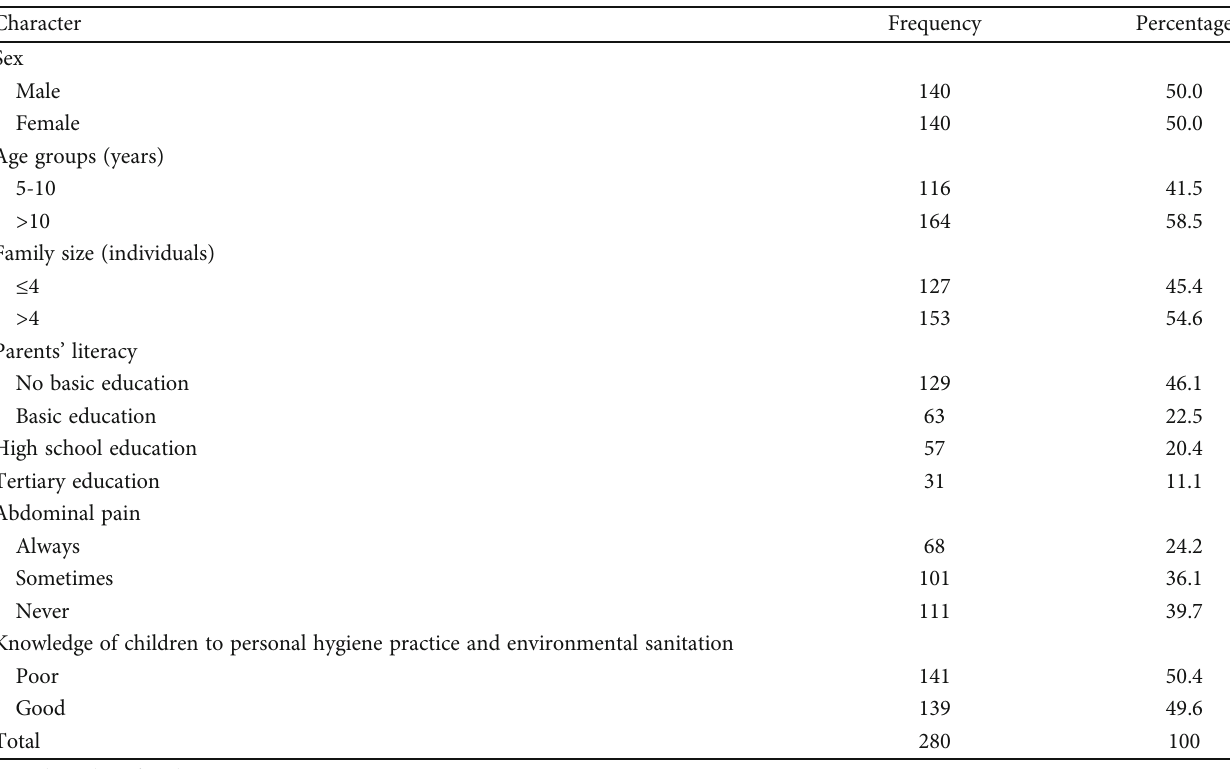
Table 1: Sociodemographic characteristics of study participants in Zeita Primary School, Merhabete district, Amhara region, Central Ethiopia, 2020 ( N = 280